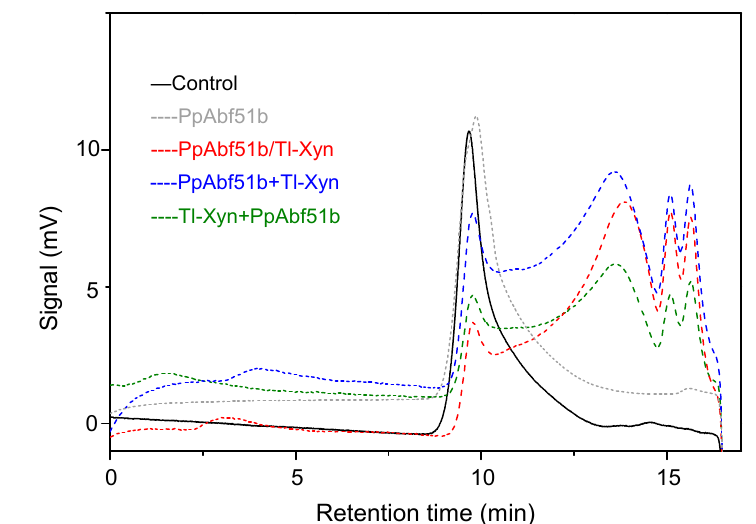
Figure 8. HPAEC analysis of the hydrolysis products of wheat arabinoxylan. ( a ) Standard, arabinose, xylose, and xylobiose; ( b ) Wheat arabinoxylan (control) was hydrolyzed by ( c ) Pp Abf51b; ( d ) Tl-Xyn, or ( e ) the combination of Pp Abf51b and Tl-Xyn.